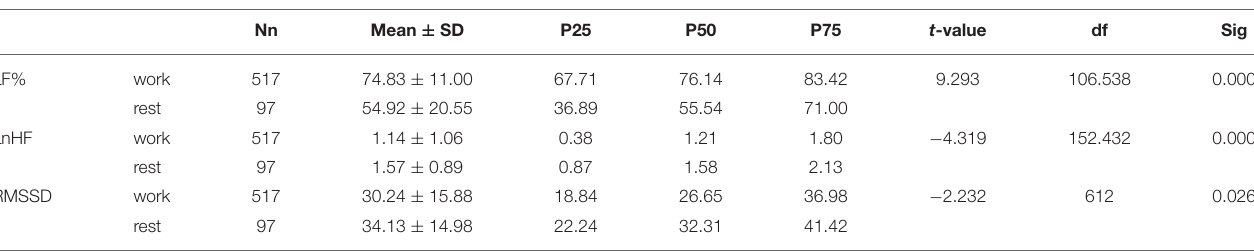
TABLE 4 | Mean differences of HRV parameters in work and rest